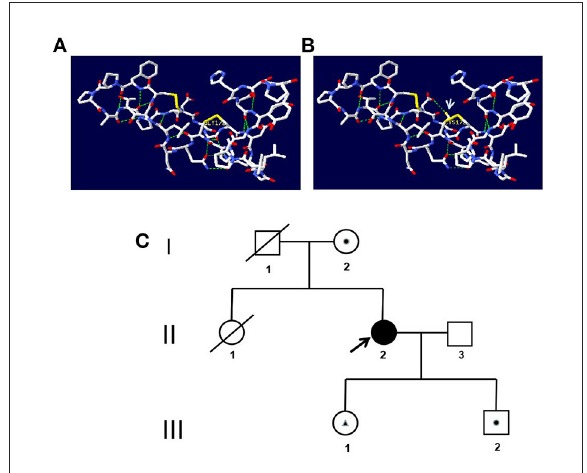
FIGURE3 (A,B) Prediction of the three-dimensional structure of the protein. (A) The wild type of p.(Gly172Cys). (B) The mutated type of p.(Gly172Cys). The arrow indicates the mutation site. (C) Genetic family tree. A square represents a male, and a circle represents a female. A shaded symbol shows the proband, and a line across the symbol shows the deceased individual. A dot within the symbol represents carrier status for mutation c.[185_186dupCA], p.(Asp63GlnfsTer18). A triangle within the symbol represents carrier status for mutation c.[154G > T],